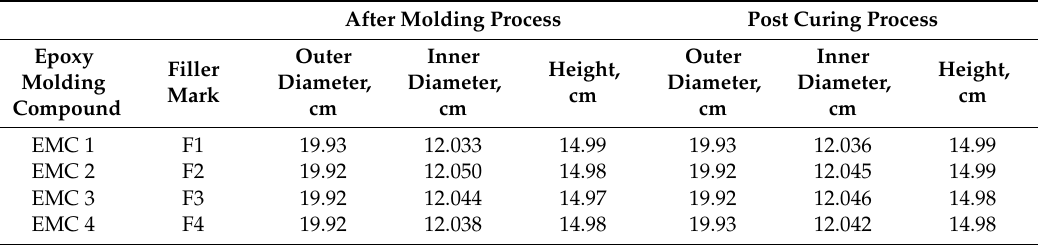
Table 4. Dimensional measurement of EMCs final test products for after molding and post curing process.